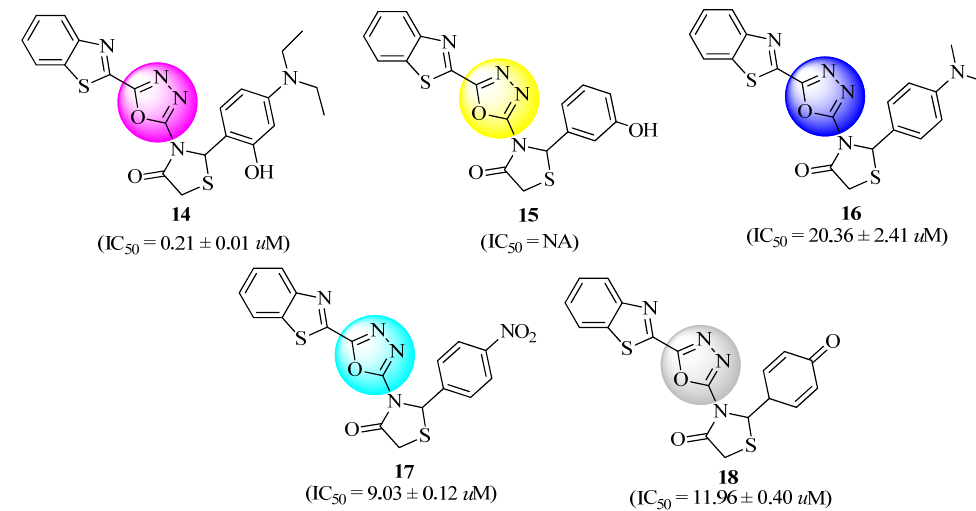
Figure 12. Synthetic analogues of benzothiazole-1,3,4-Oxadiazole-4-thiazolidinone.